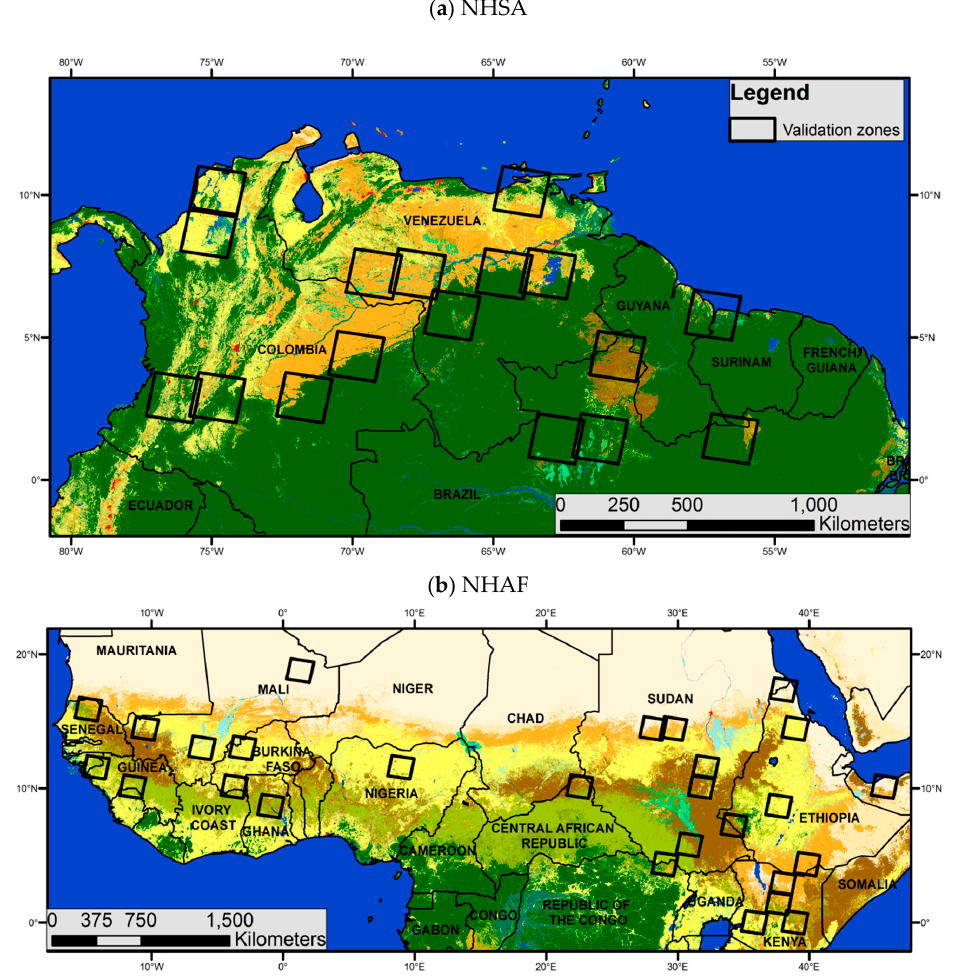
Figure 4. Study area, 44 Validation scenes are shown as black rectangles that correspond to the extent of a LANDSAT image. ( a ) NHSA, ( b ) NHAF. The different land cover types art shown in a map from of a LANDSAT image. ( a ) NHSA, ( b ) NHAF. The di ff erent land cover types art shown in a map from the CCI-LC project of (ESA) http://maps.elie.ucl.ac.be/CCI/viewer/. the CCI-LC project of (ESA) http: // maps.elie.ucl.ac.be / CCI / viewer /